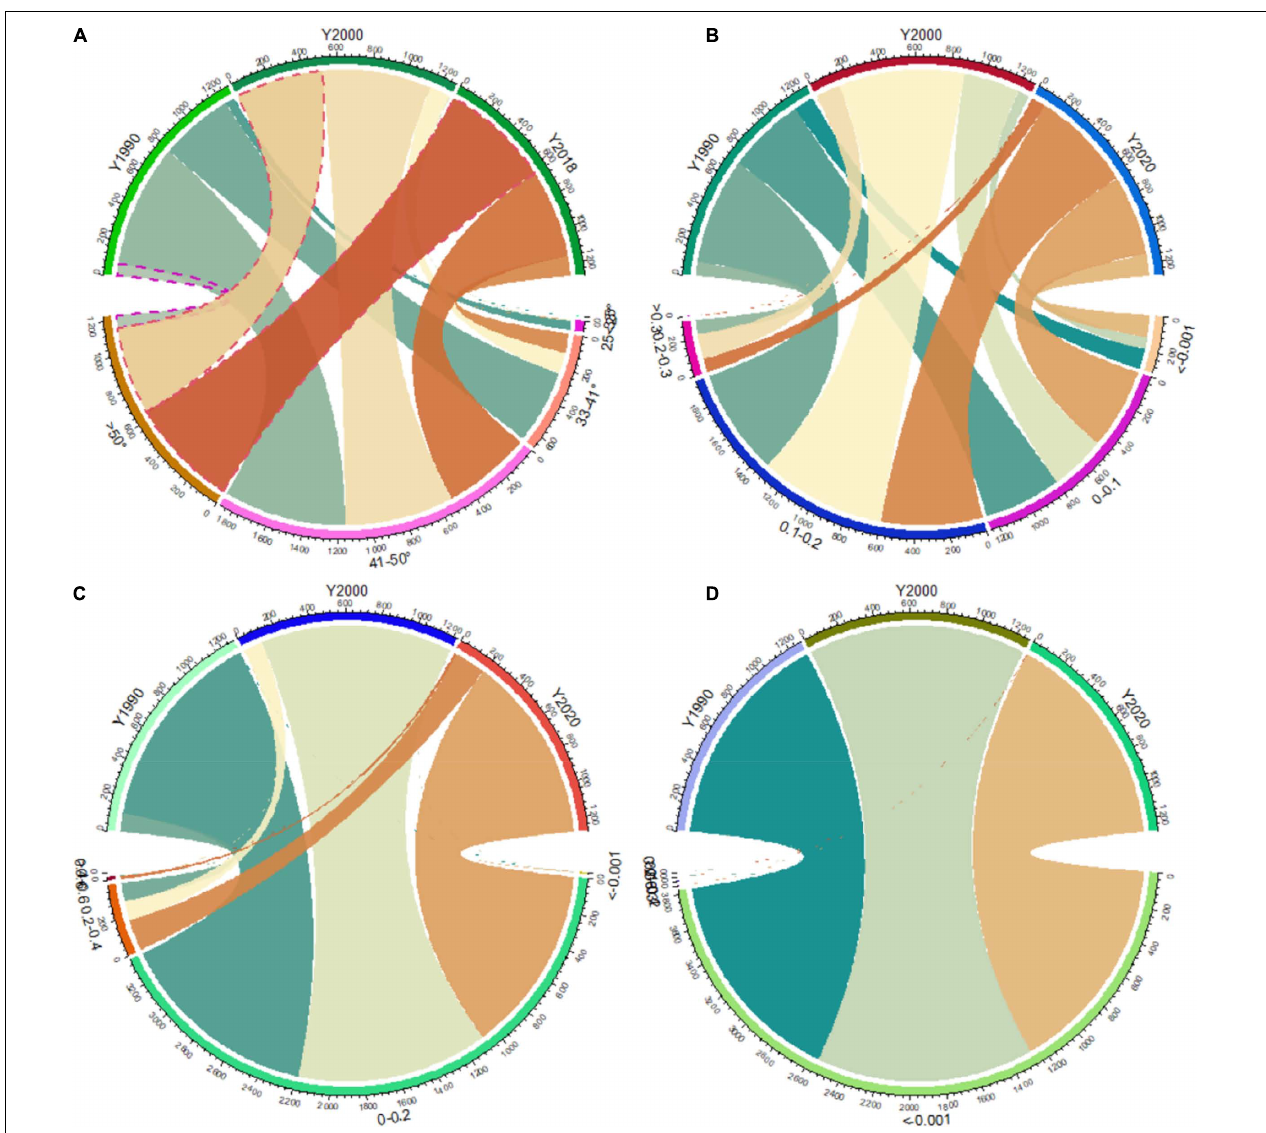
FIGURE 3 | The transition during the period of 1990–2018 for (A) LST, and urban biophysical parameters, like (B) NDBI, (C) NDVI, and (D)